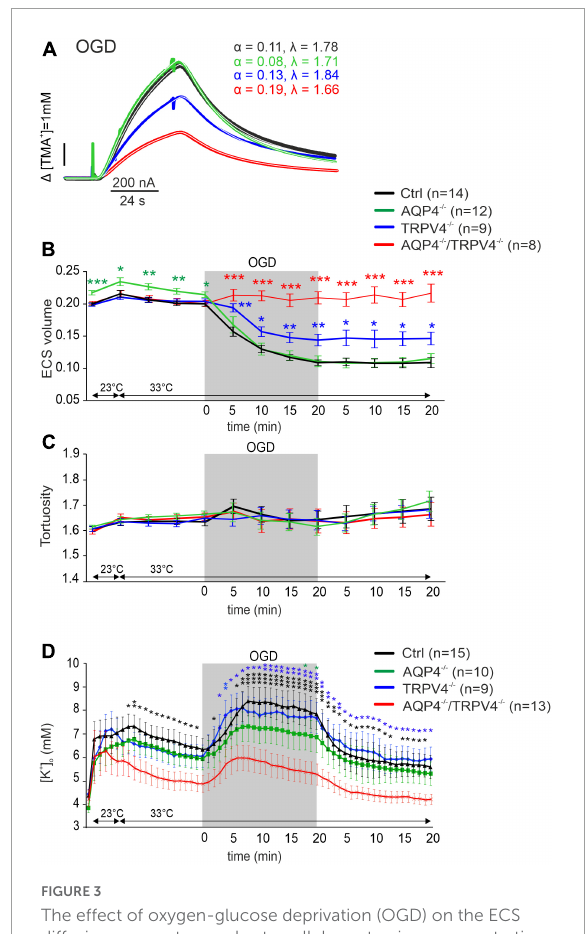
FIGURE3 The effect of oxygen-glucose deprivation (OGD) on the ECS diffusion parameters and extracellular potassium concentration [K + ] o in situ . (A) Representative diffusion curves with the corresponding values of the ECS volume fraction ( α ) and tortuosity ( λ ) recorded in the Ctrl, AQP4 − / − , TRPV4 − / − , and AQP4 − / − /TRPV4 − / − mice. Averaged data of α (B) and λ (C) measured in the Ctrl, AQP4 − / − , TRPV4 − / − , and AQP4 − / − /TRPV4 − / − mice at resting conditions (22–24 ◦ C), 33 ◦ C and at 5-min intervals during and after (washout) OGD. Asterisks indicate significant differences between Ctrl and AQP4 − / − , TRPV4 − / − , or AQP4 − / − /TRPV4 − / − mice (* p < 0.05, ** p < 0.01, *** p < 0.001). (D) Values of [K + ] o recorded in 1-min intervals in the Ctrl, AQP4 − / − , TRPV4 − / − , and AQP4 − / − /TRPV4 − / − mice. Data are presented as mean ± SEM. Asterisks indicate significant differences between AQP4 − / − /TRPV4 − / − mice and AQP4 − / − , TRPV4 − / − , or Ctrl (* p < 0.05, ** p < 0.01, *** p < 0.001). Ctrl, control; AQP4 − / − , AQP4-deficient mice; TRPV4 − / − , TRPV4-deficient mice; AQP4 − / − /TRPV4 − / − , AQP4- and TRPV4-deficient mice; OGD, oxygen-glucose deprivation; n , number of slices; ECS, extracellular space.